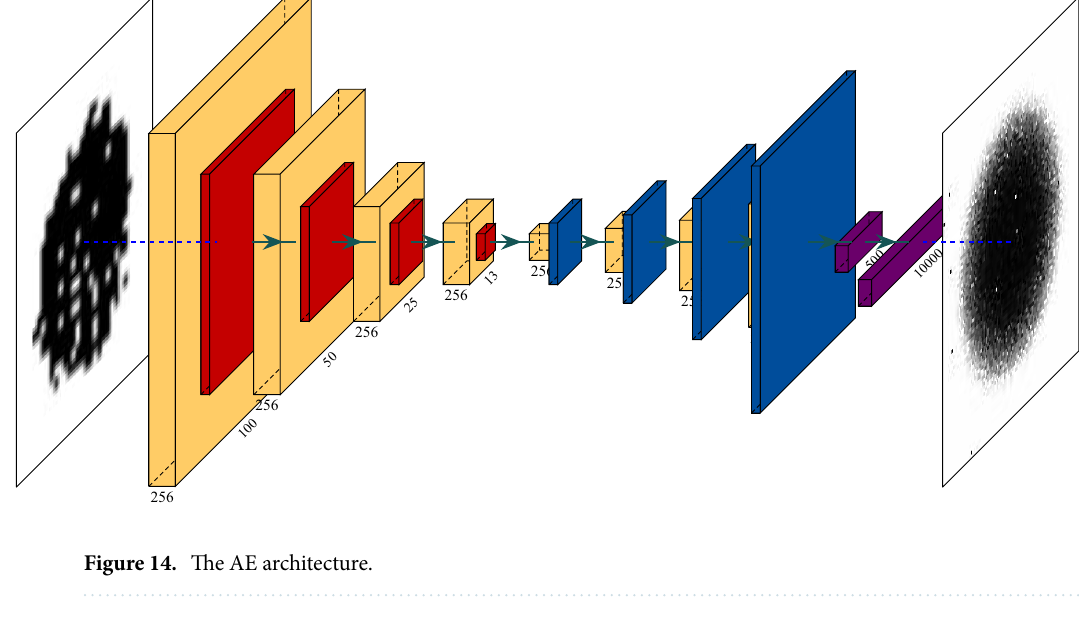
Figure 14. The AE architecture.